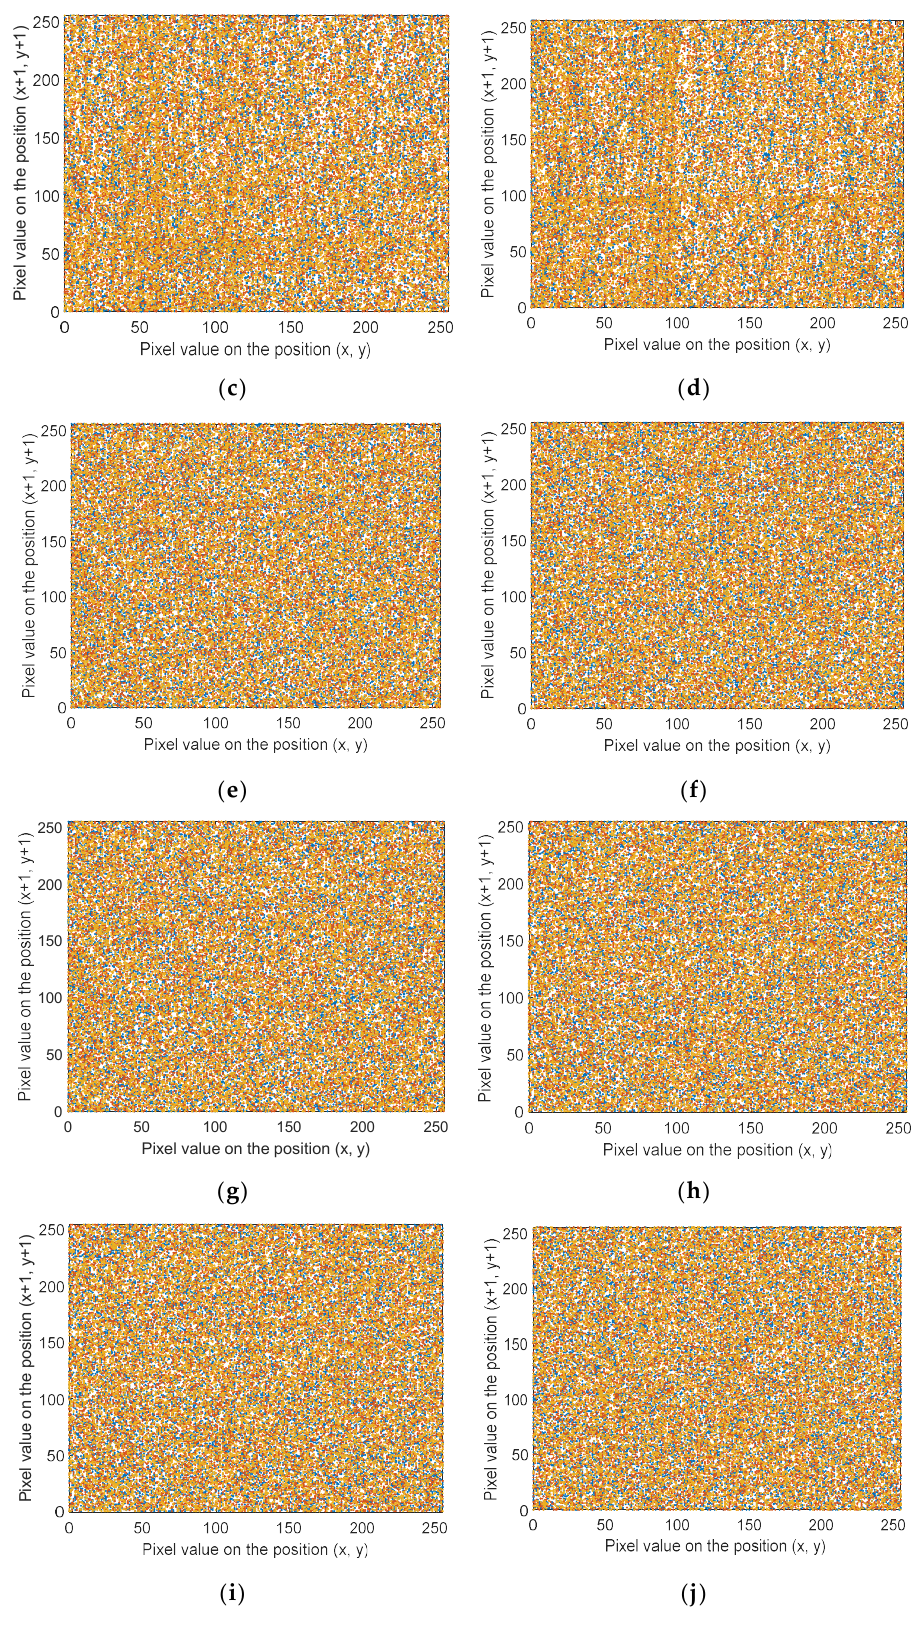
Figure 19. Correlation analysis of encrypted images: ( a ) correlation of encrypted Peppers; ( b ) cor- relation of encrypted Baboon; ( c ) correlation of encrypted Airplane; ( d ) correlation of